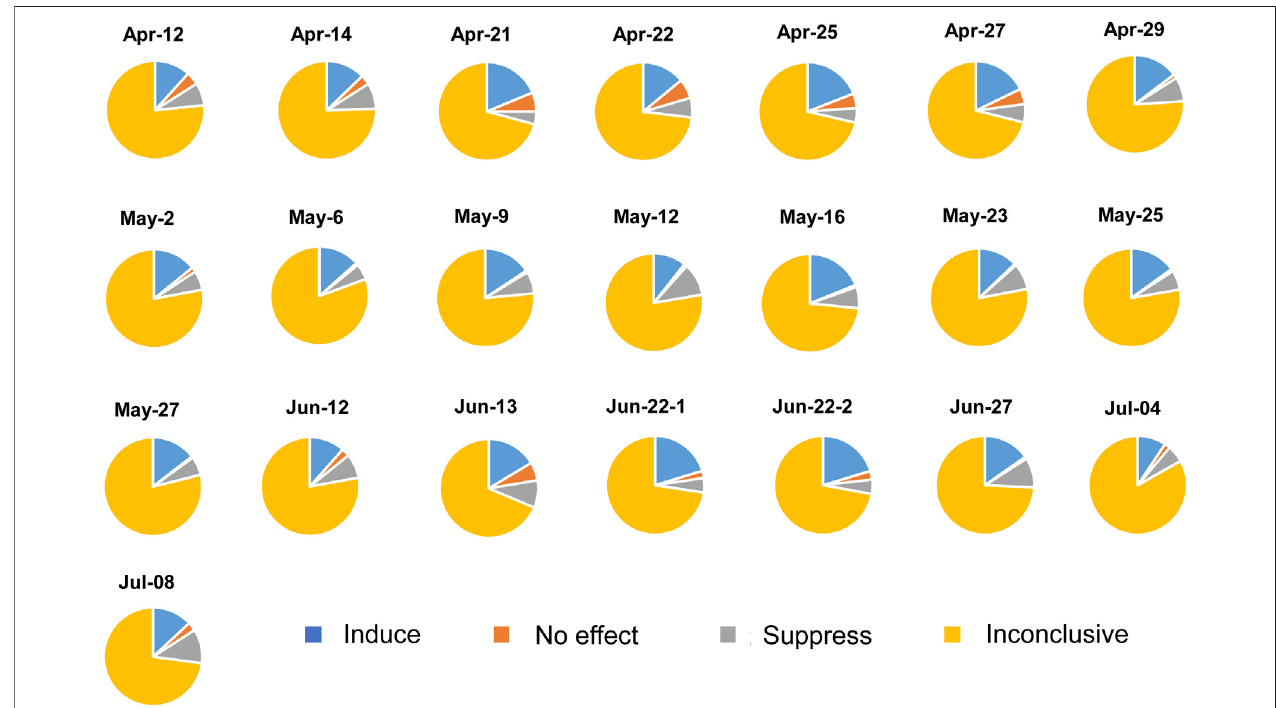
FIGURE 4 | Percentage of chemical contaminants that induce, has no effect or suppress reactive oxygen species (ROS). Chemical contaminants that do not have available literature on ROS production are classi fi ed as inconclusive compounds.